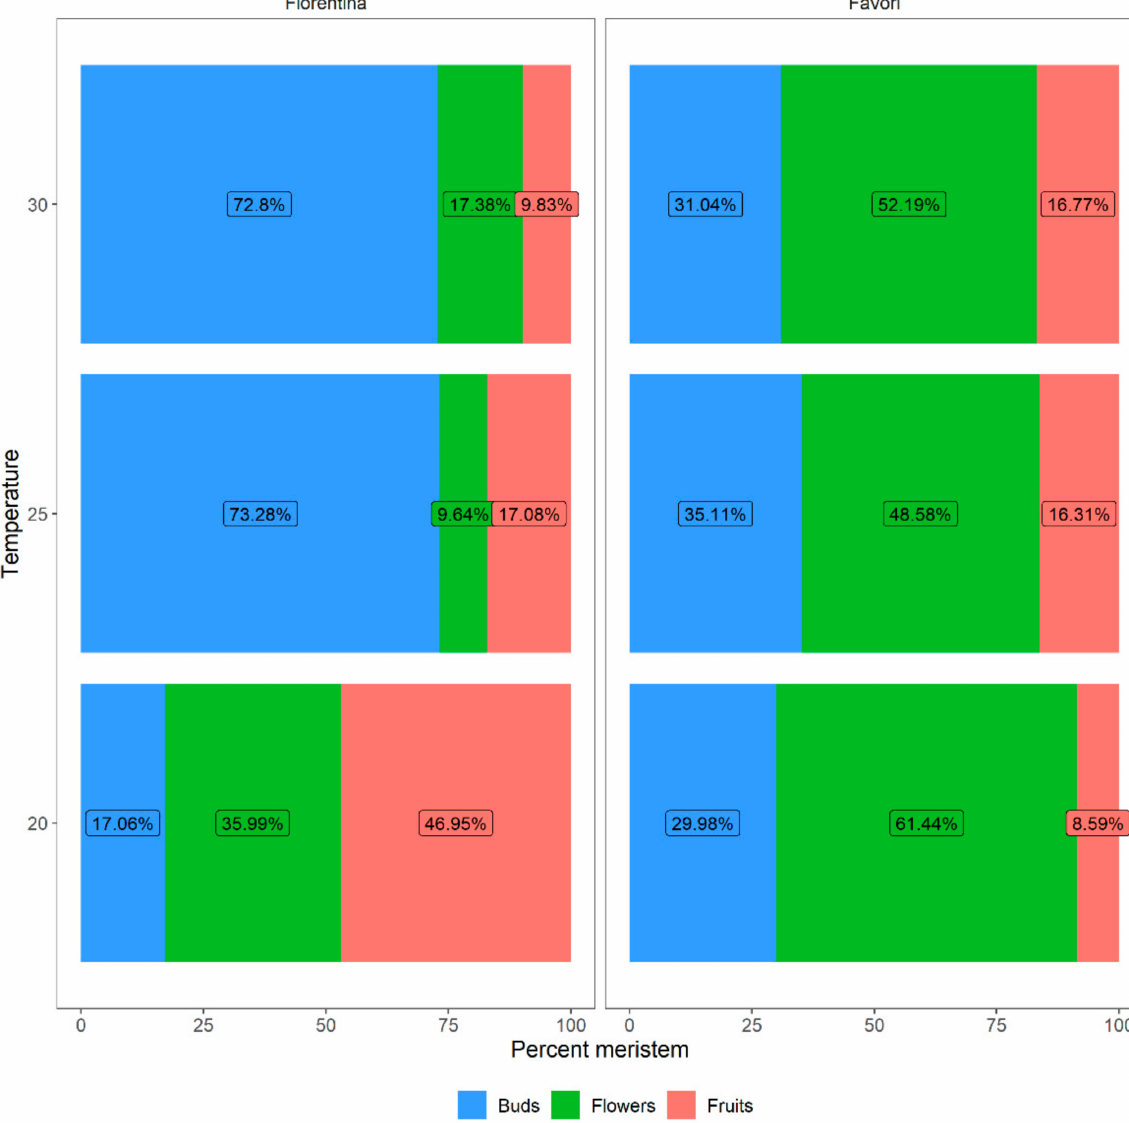
Figure 7. The percentages of meristems that differentiated into flowers and fruits for plants of the strawberry cultivars ‘Florentina’ and ‘Favori’ treated at three temperatures (20 ◦ C, 25 ◦ C, and 30 ◦ C). The buds that were below S9 (fully differentiated flower) were compiled as